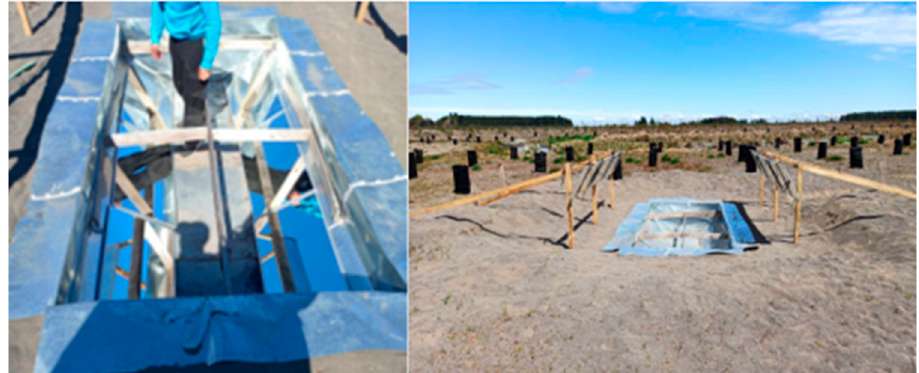
Figure 1. Canal and panels installed. The left figure shows the arrangement of the aluminum mirrors inside the canal, which are installed in the required conditions.